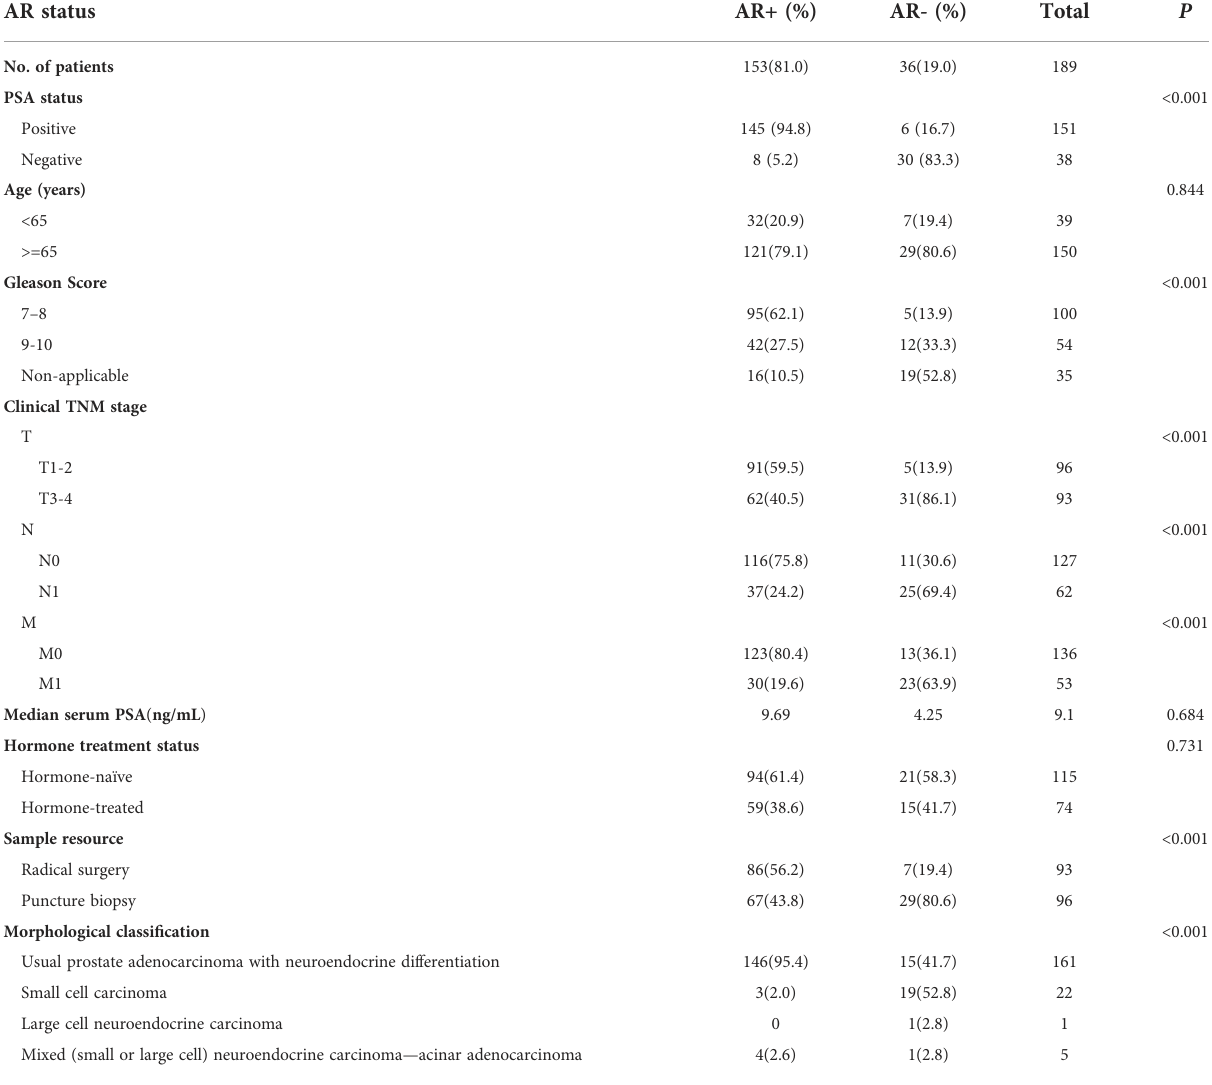
TABLE 3 Baseline and clinicopathological characteristics of prostate cancer with neuroendocrine differentiation